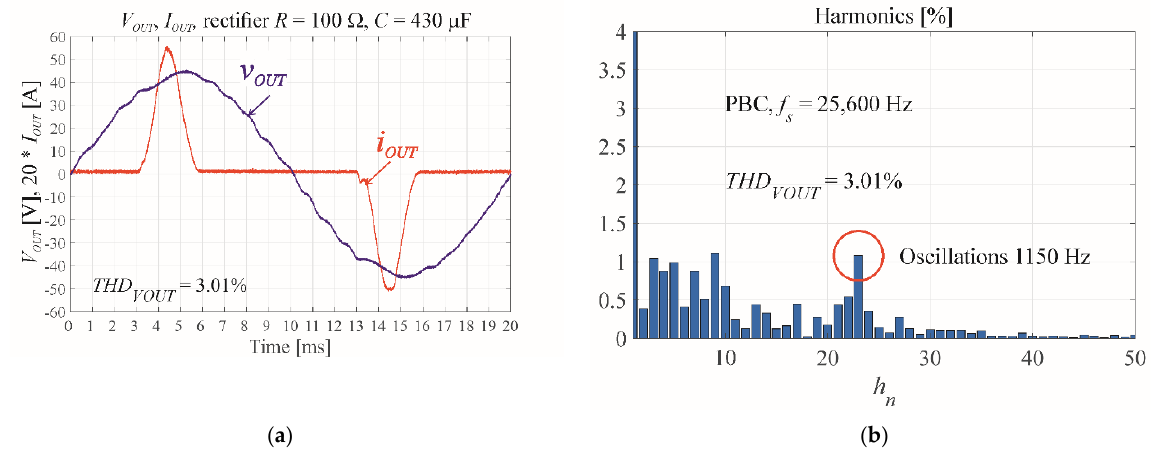
Figure 12. ( a ) The output voltage and current; ( b ) The harmonics analysis for the PBC with the experimentally adjusted border gains ( R i = 3, K v = 0.5, R i ’ = 5.49, K v ’ = 0.92) for f s = 25,600 Hz (RC load: R = 50 Ω , C = 430 μ F).